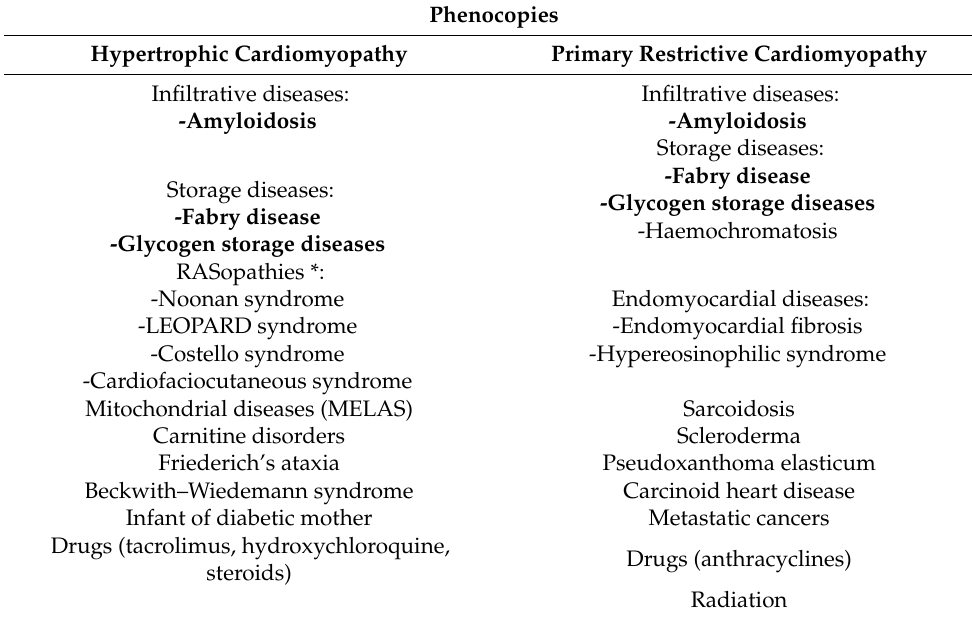
Table 1. Phenocopies of hypertrophic cardiomyopathy and primary restrictive cardiomyopathy.